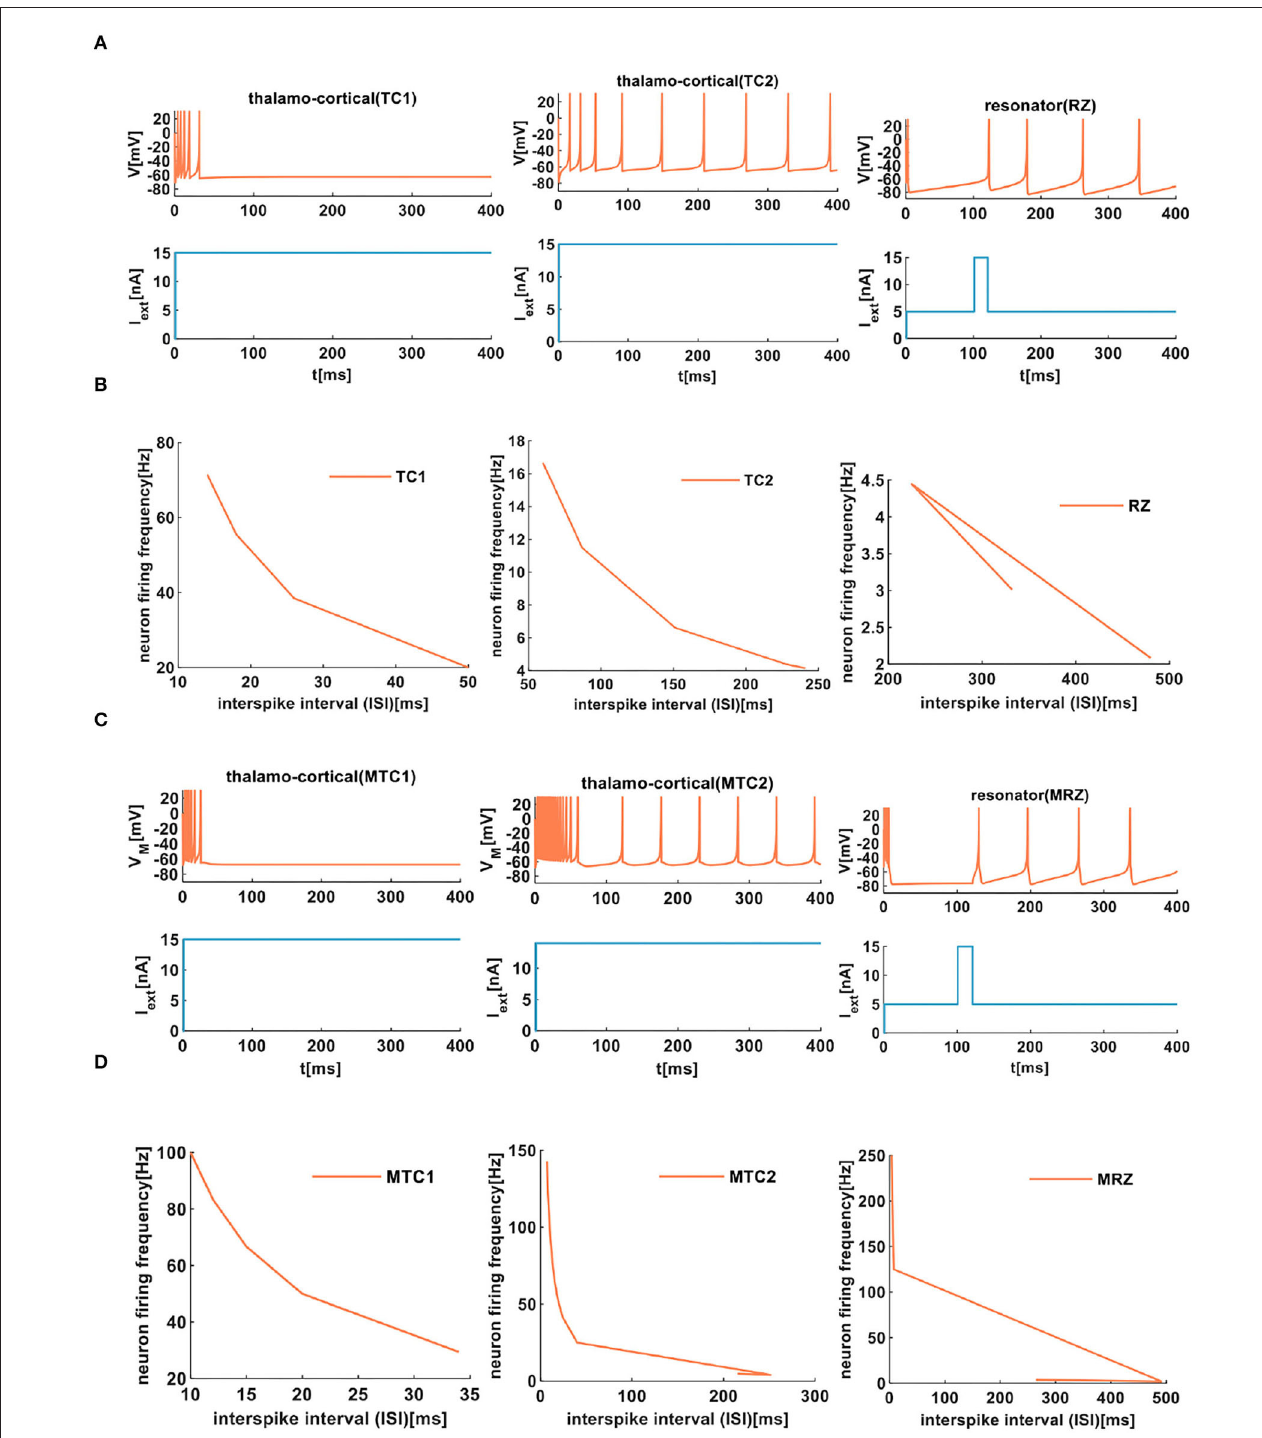
FIGURE 8 | The firing behaviors of other cortical neurons are produced by the IZH spiking model and the MIZH spiking model. (A) The firing patterns of the thalamocortical neuron and the resonator neuron for the IZH spiking model (in our simulation, the values of parameters are a = 0.1, b = 0.02, c = − 65, d = 0.26, and I ext = 15 nA for the TC1 neurons; a = 0.008, b = 0.03, c = − 65, d = 0.26, and I ext = 15 nA for the TC2 neurons; a = 0.01, b = 0.26, c = − 65, d = 20, and I ext = 15 nA for the RZ neurons). (B) The evolution of the neuron firing rate versus the inter-spike interval for the TC1, TC2, and RZ neurons of the IZH spiking model. (C) The firing patterns of the thalamocortical neuron and the resonator neuron for the MIZH spiking model (the values of parameters are a = 0.1, c = − 65, d = 0.26, and I ext = 15 nA for the MTC1 neurons; a = 0.01, c = − 60, d = 1, and I ext = 15 nA for the MTC2 neurons; a = 0.01, c = − 65, d = 20, and I ext = 15 nA for the MRZ neurons). (D) The evolution of the neuron firing rate versus the inter-spike interval for the MTC1, MTC2, and MRZ neurons of the MIZH spiking model.